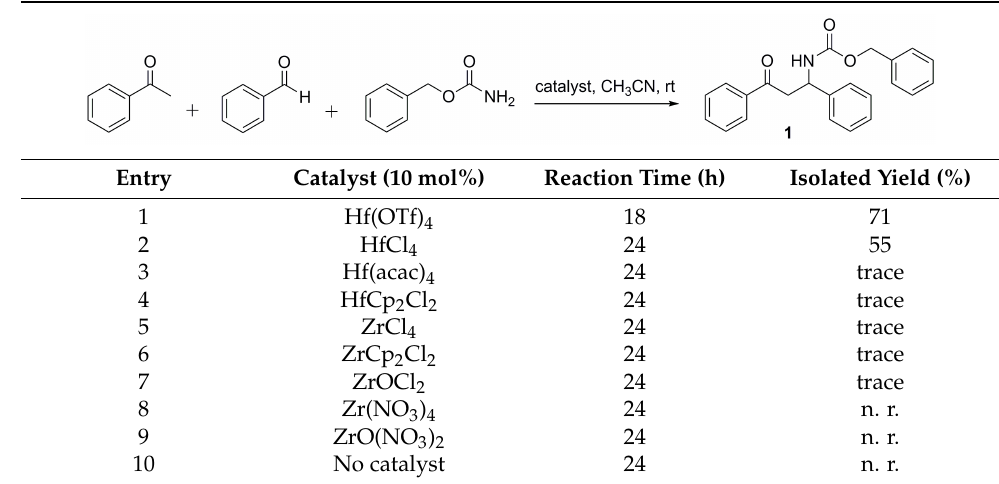
Table 1. Catalytic effects of Group IVB transition metal Lewis acids on the three-component synthesis of 1 1 .